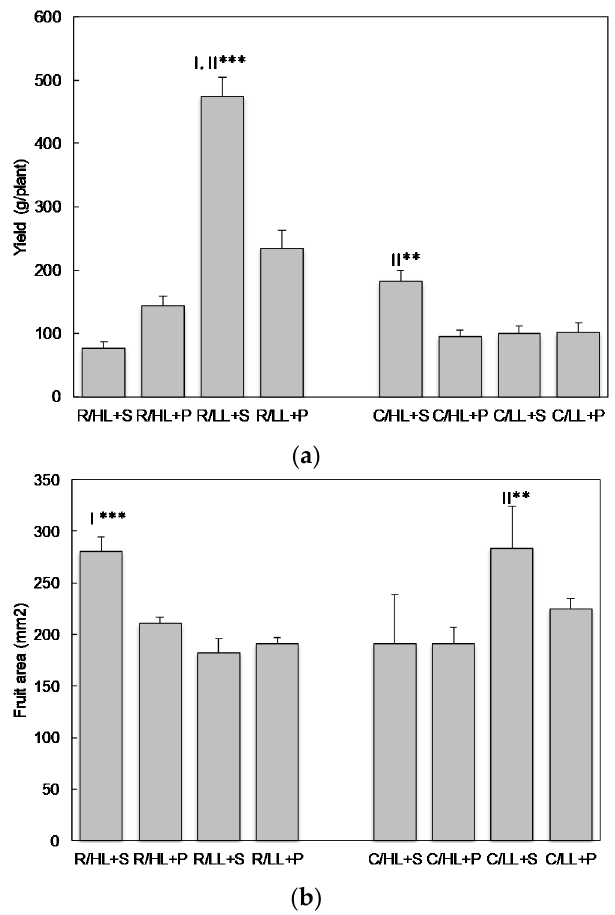
Figure 1. ( a ): Effect of light intensity and substrate composition on fruit yield in two Rubus idaeus L. cultivars (Ruvi and Cayuga). Fruit yield was determined by weighting the fruits pooled from eight plant that were included in the experimental work ( b ): Correlation between the cultivar, light intensity and substrate composition on fruit area. Fruit area was calculated using Image J software (I, ‘Ruvi’ plants; II, ‘Cayuga’ plants; The symbol *** indicates p < 0.001, and the symbol ** indicates p < 0.005).